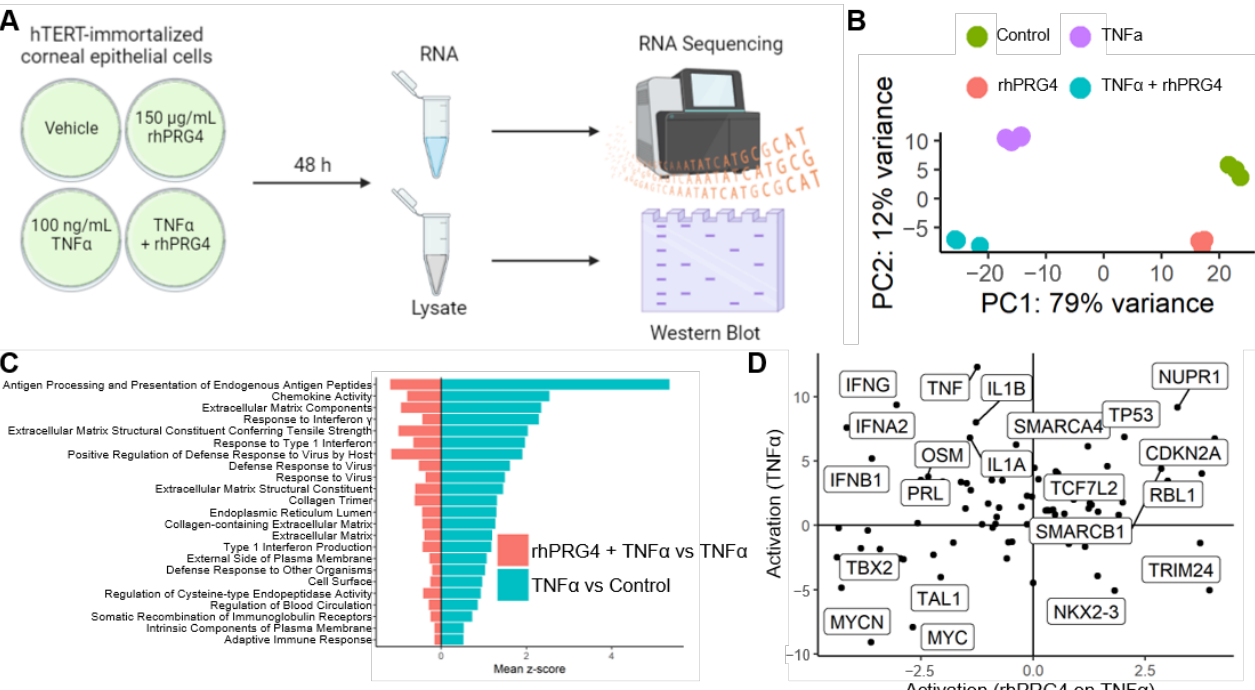
Figure 1. The effect of recombinant human proteoglycan 4 (rhPRG4) on tumor necrosis factor α (TNF α )-stimulated inflammatory activity at the RNA level ( A ) Experimental setup for collecting RNA and cell lysate from hTERT-immortalized corneal epithelial (hTCEpi) cells. Created with BioRender.com ( B ) Principal component analysis of the expression of 500 most variable genes showing the consistent large (~79% variance) effect of the TNF α and the effect of rhPRG4 on the x and y -axes. ( C ) Gene Ontology gene sets that are positively regulated by TNF α on control and down-regulated by the application of rhPRG4 on TNF α treated samples. ( D ) The activation z-score (calculated using the expression of downstream genes) of upstream regulators for TNF α treatment ( y -axis) and the addition of rhPRG4 treatment on TNF α ( x -axis).